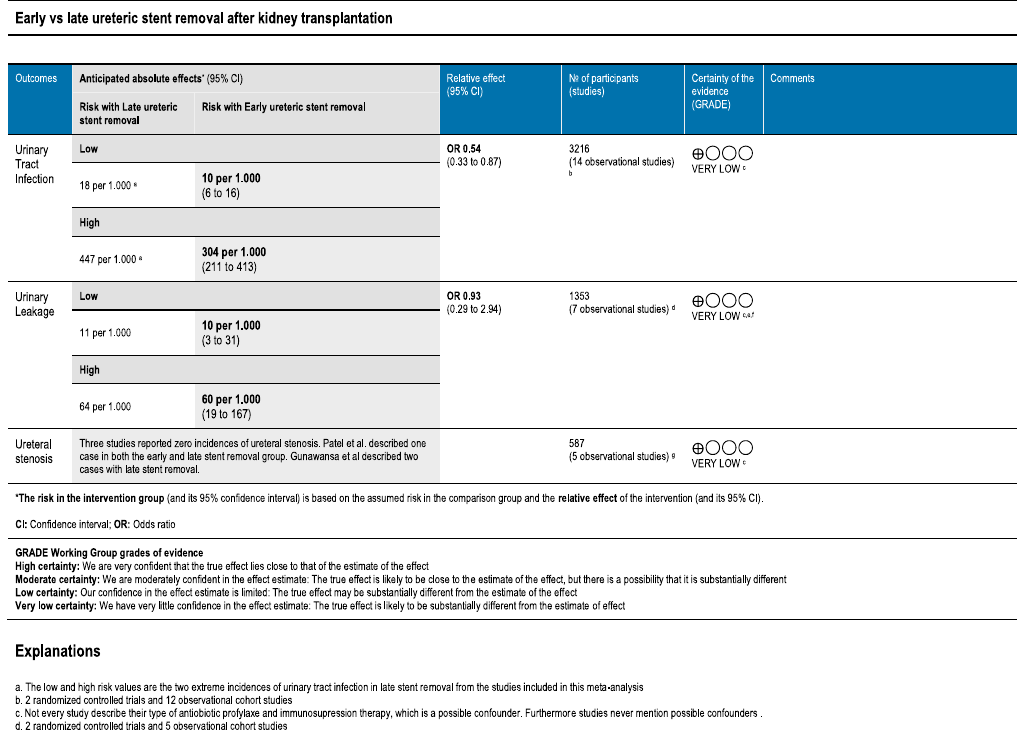
Figure 2. Quality assessment of the included studies.